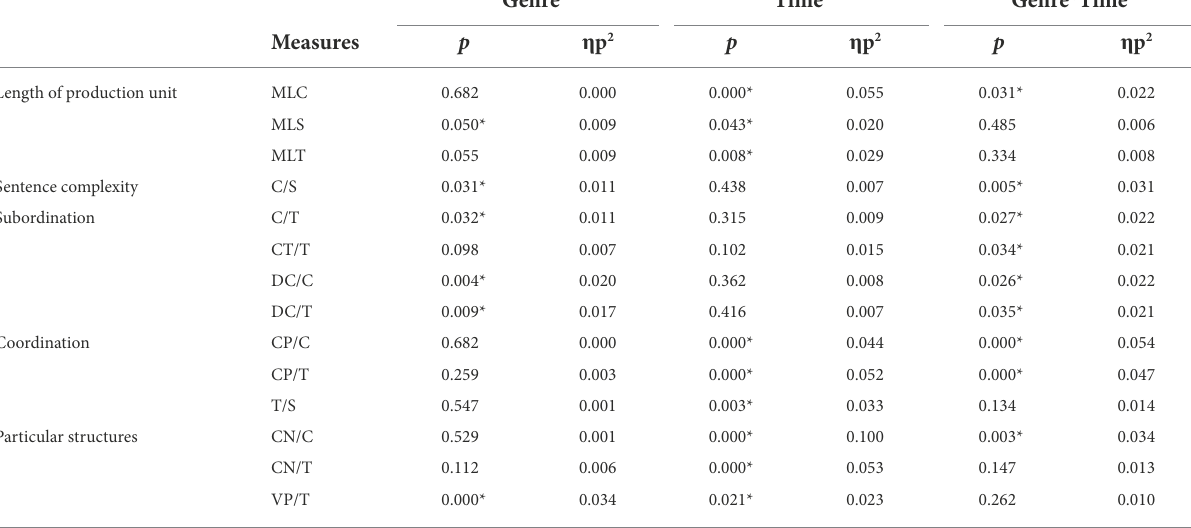
TABLE 6 Genre effects on syntactic complexity measures (two-way repeated measures